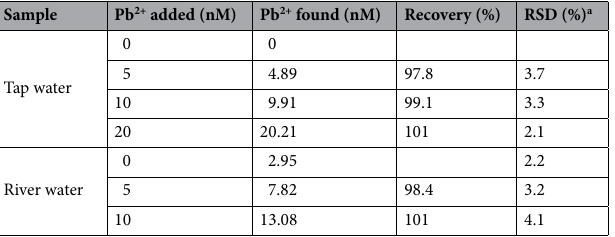
Table 2. Obtained results for the determination of Pb 2+ in real samples. a Relative standard deviation values based on three